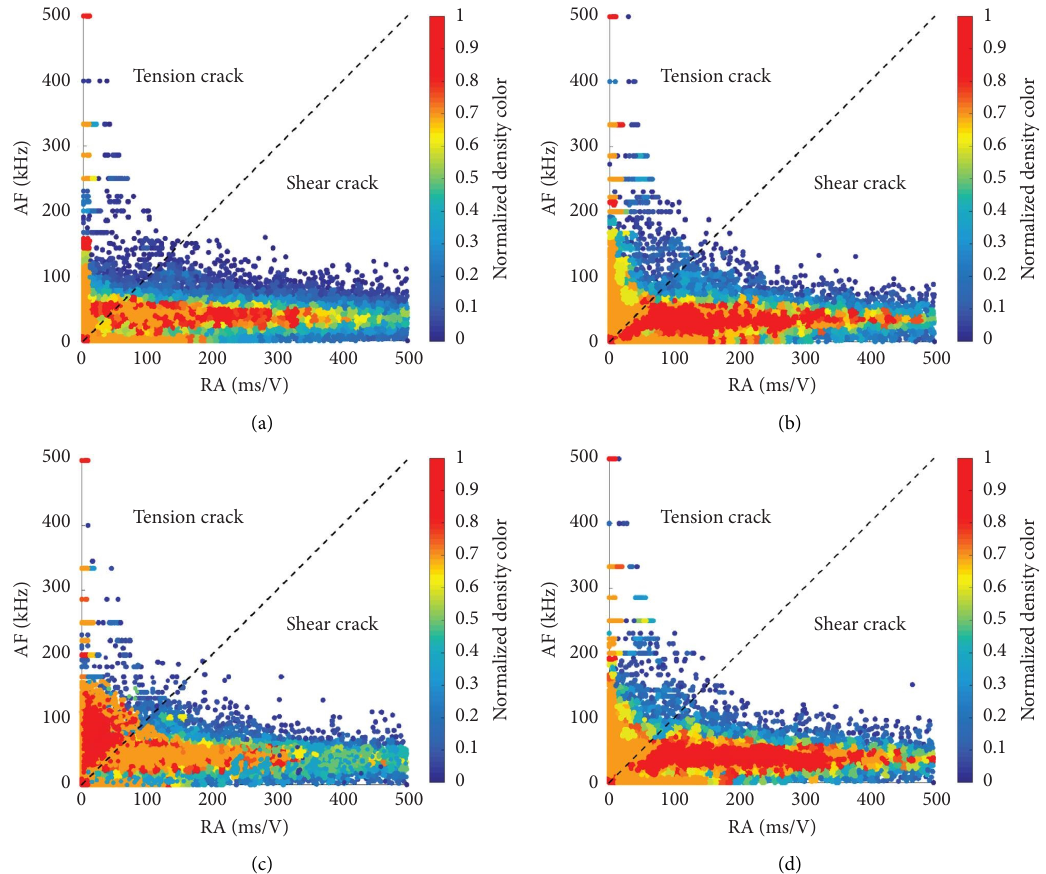
Figure 7: RA-AF distribution of AE signal timing parameters. (a) QSY